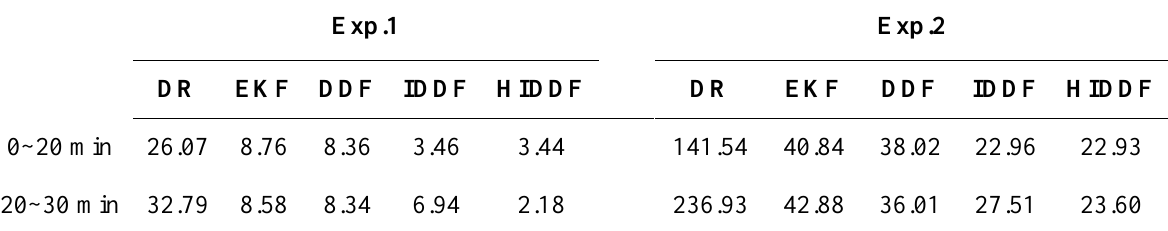
Table 2. Localization errors of different methods.